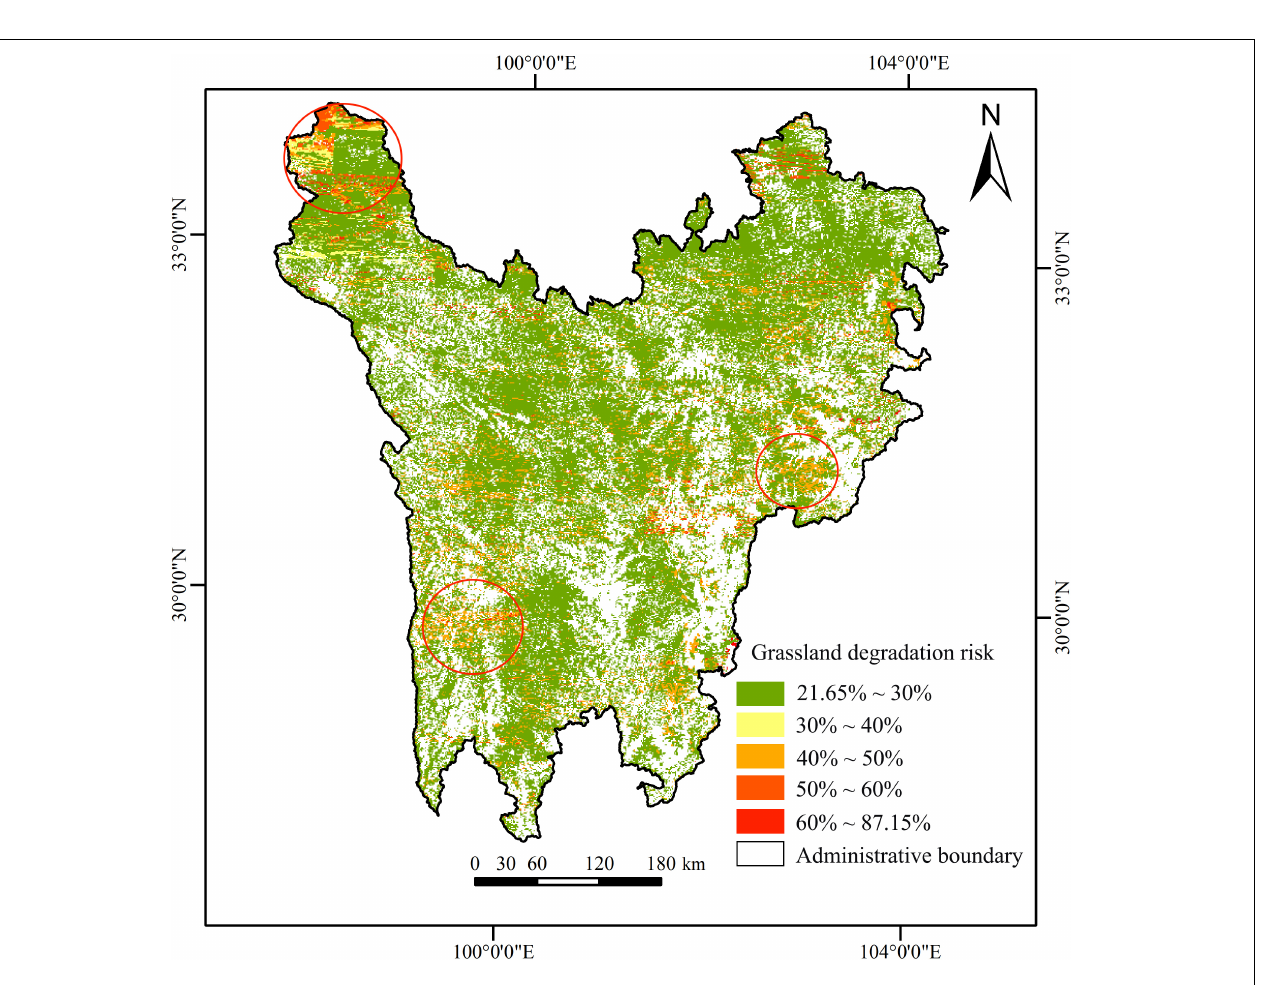
FIGURE 12 | Distribution of grassland degradation